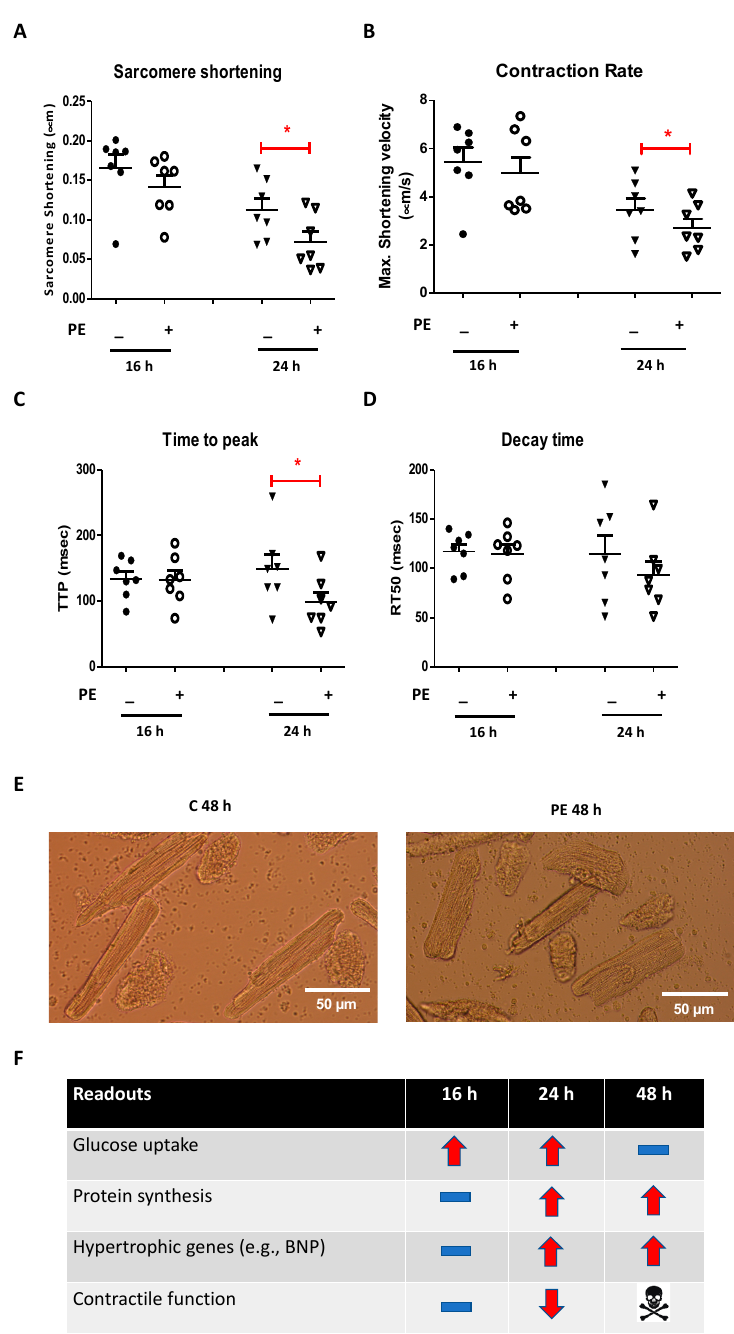
Figure 4. Contractile properties of isolated cardiomyocytes after 16 h, 24 h, and 48 h phenylephrine (50 µ M) treatment, at 1 Hz electric-field stimulation, and a summary of the main findings with respect to the established in vitro model of cardiac hypertrophy. ( A – D ) Sarcomere shortening, contraction rate, time to peak, and decay time after 16 h and 24 h phenylephrine stimulation compared to that of control. ( E ) Representative pictures of control and phenylephrine-stimulated cells after 48 h culture. ( F ) Table depicting the effects of phenylephrine treatment on glucose uptake, protein synthesis, hypertrophic gene expression, and contractile function after 16 h, 24 h, and 48 h phenylephrine stimulation. The minus symbols indicate no change. The arrows up and down indicate an increase or decrease, respectively. The hazard symbol indicates that the cells died. Values are expressed as means ± STDEV for each incubation time ( n = 7; imaging of 10 cells/condition). * p < 0.05 was considered significantly different compared to control at the same incubation time.